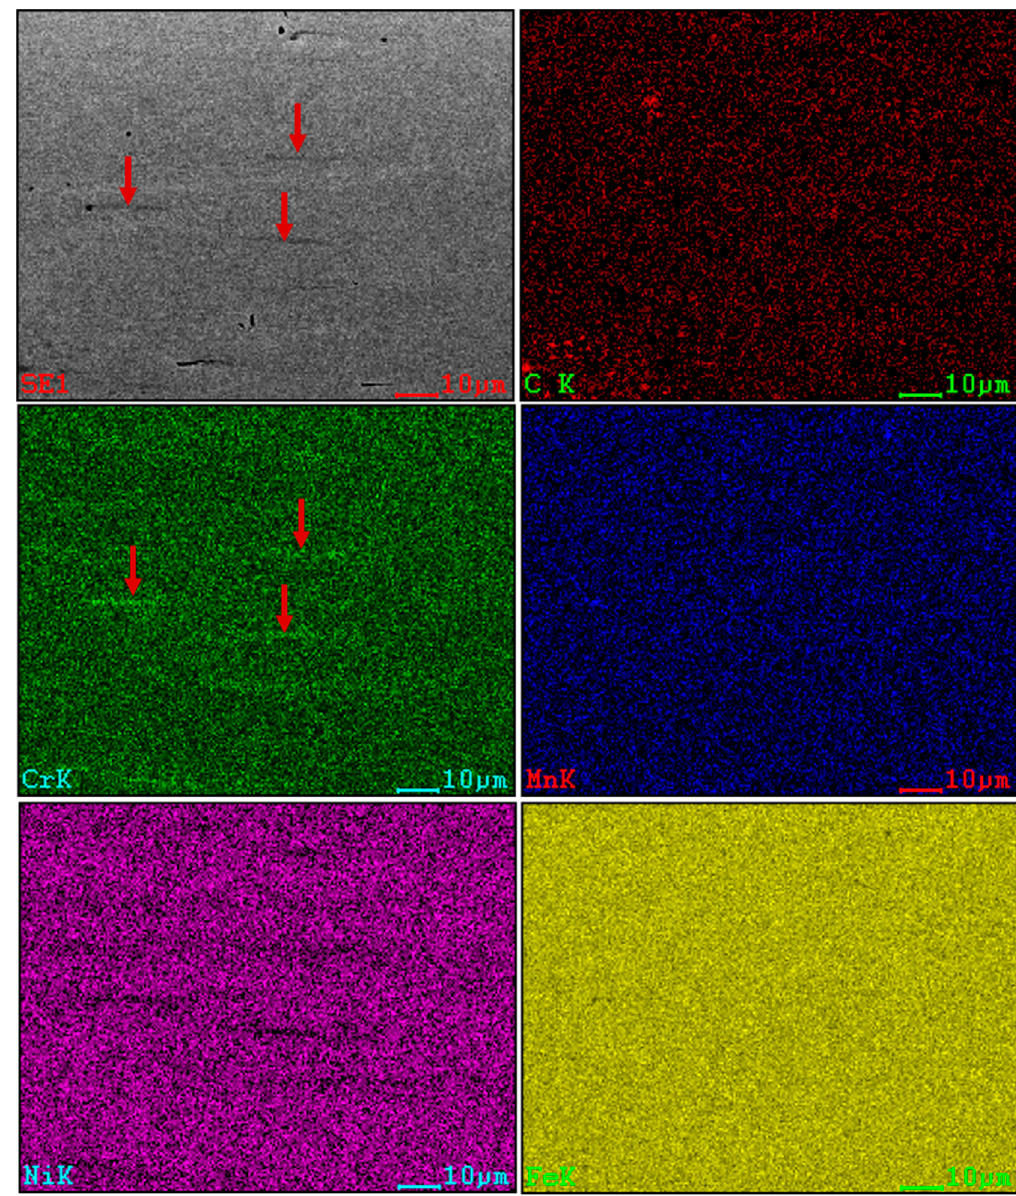
Figure 4. SEM photo of etched 301ASS-0.4Cu and surface scan photos of the main alloying ele- ments.